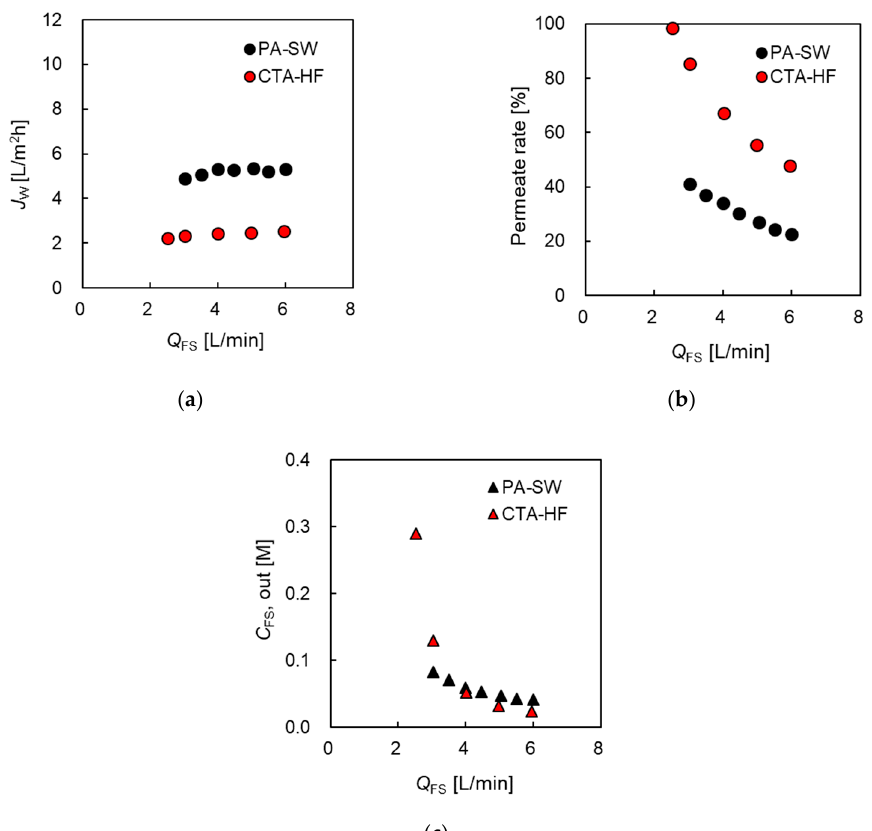
Figure 5. ( a ) Water flux, J w , and ( b ) FS permeation rate, η , and ( c ) the concentration of the module outlet at FS side ( C FS,out ), respectively, as a function of FS flow rate, Q FS . DS: 1.2 M NaCl. FS: treated tap water. Q DS : 10.0 L/min. Δ P : 1.6 MPa for PA-SW module and 2.5 MPa for CTA-HF module.